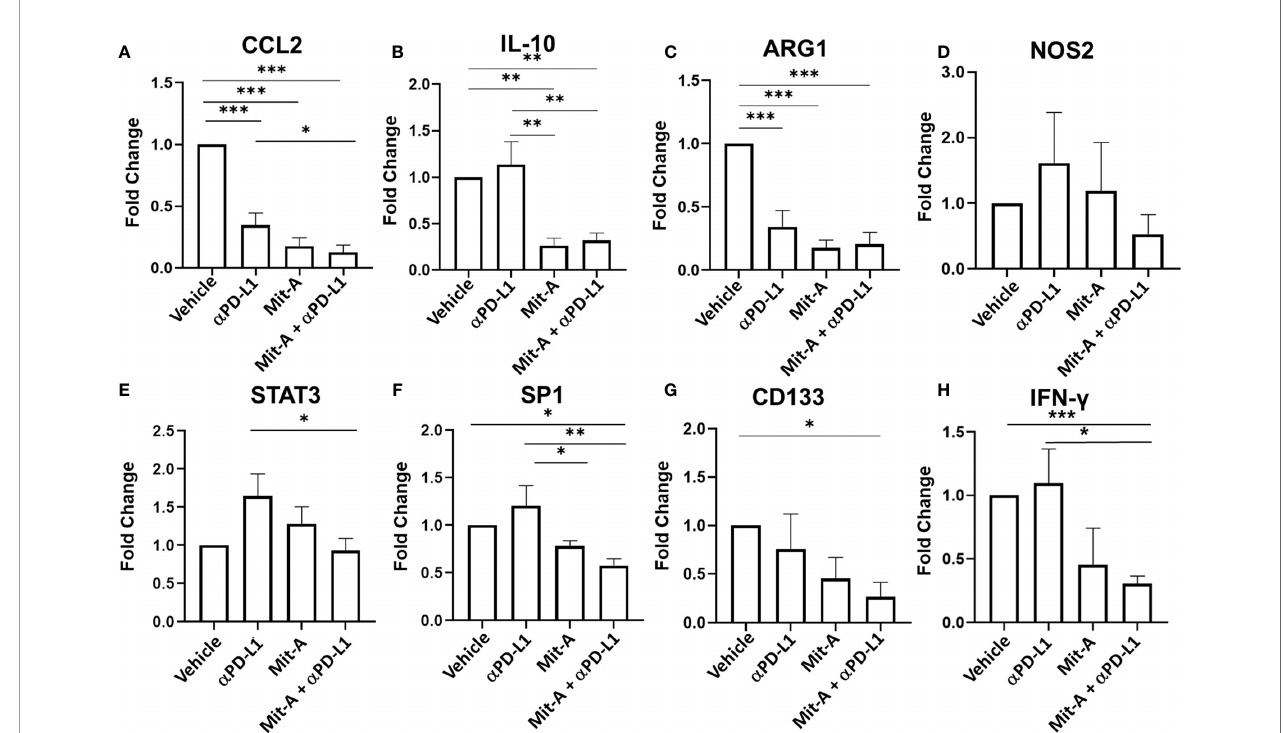
FIGURE 6 | Mit-A in combination with a PD-L1 mAb suppresses the g-MDSCs along with CSCs. Total RNA was isolated from the MC38 orthotopic tumors of the treatment groups (vehicle, isotype (IgG), Mit-A with or without a PD-L1 mAb), and subjected to qPCR analyses of (A) CCL2 , (B) IL-10 , (C) ARG1 , (D) NOS2 , (E) STAT3 , (F) SP1 , (G) CD133 and (H) IFN- g transcripts (n = 3). The vehicle and group was normalized and other groups were compared with the normalized control (vehicle) group. Gene expressions of vehicle and isotype were found to be similar. Data analyzed as mean ± SEM by One way ANOVA (Fischer ’ s LSD test). *p < 0.05, **p < 0.01, ***p < 0.001. A representative of two experiments is